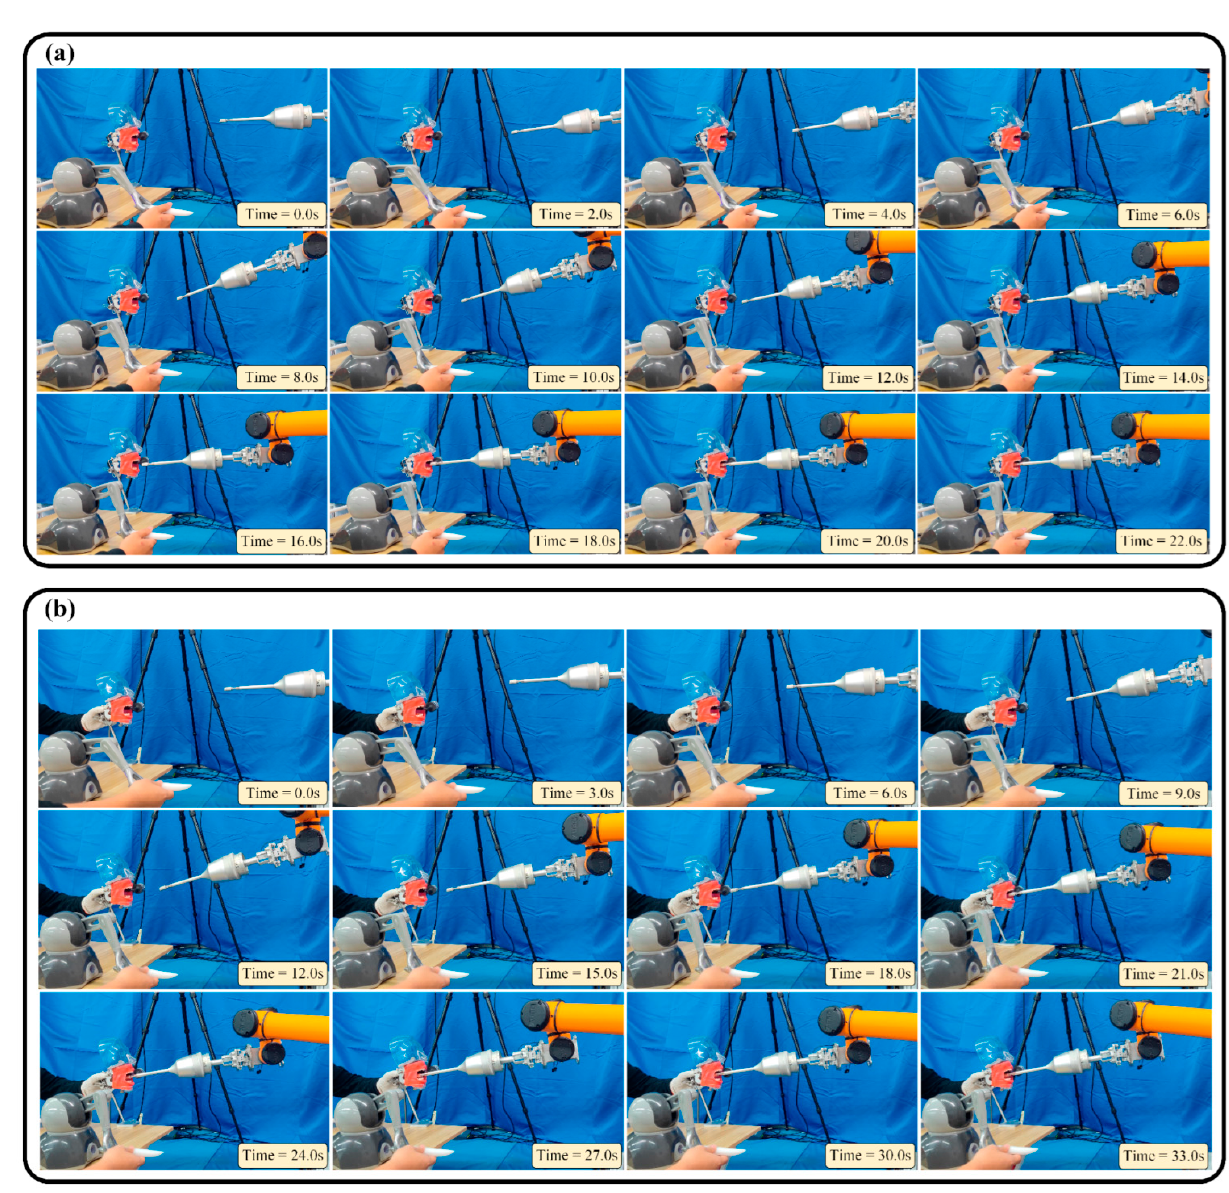
Figure 19. The motion process of manual operation: ( a ) Static and manual feeding. ( b ) Dynamic and manual feeding.